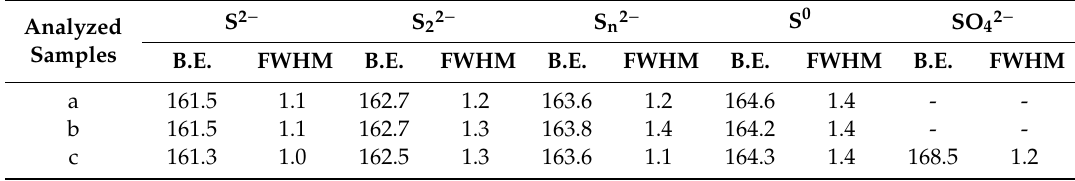
Table 1. Binding energy and full width at half maxima of sulfur specie in XPS